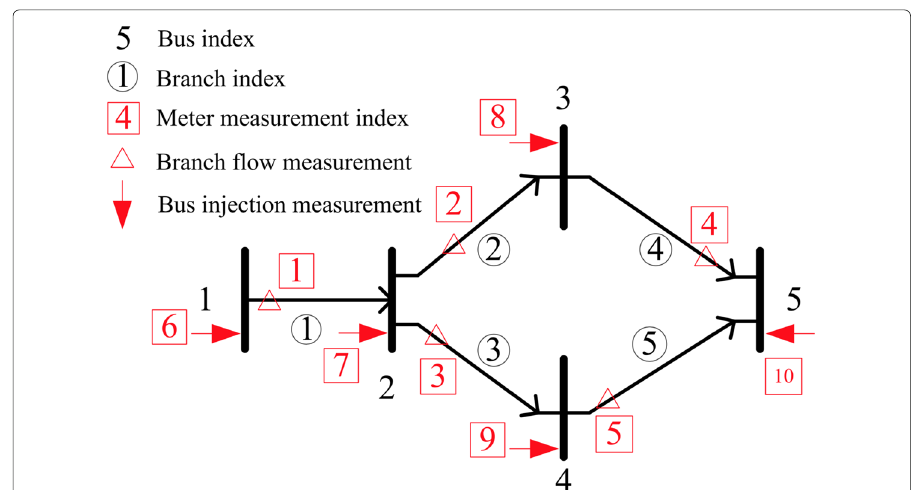
Fig. 7 A fully measured 5-bus power system. Taken from (Deng et al.